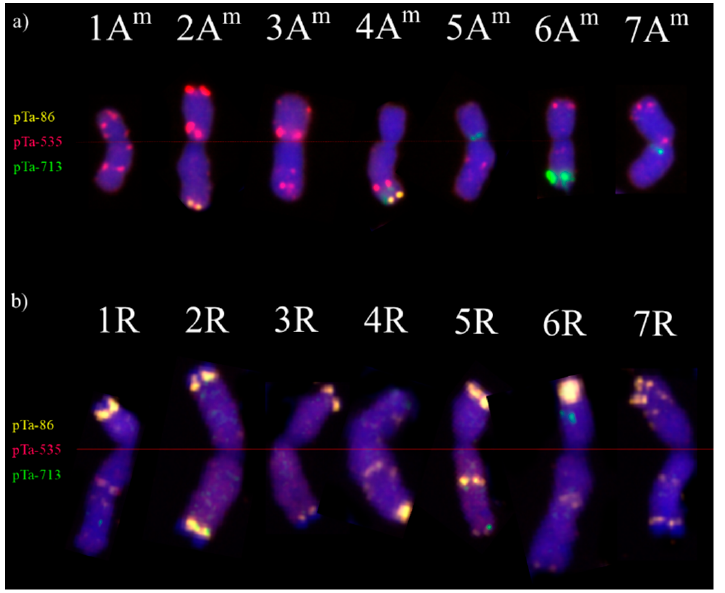
Figure 2. Karyotypes of ( a ) T. monococcum PI 191383 accession and ( b ) rye cv. Hadron. Yellow FISH signals are from probe pTa-86, red signals—pTa-535 and green signals are from probe